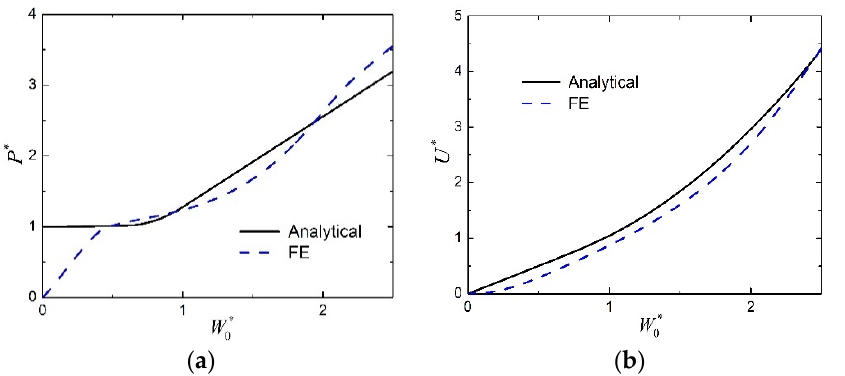
Figure 5. Comparison between analytical predictions and numerical results for the large deflection response of FML sandwich beams under transverse loading (Case 1): ( a ) Load versus midspan deflection; ( b ) absorbed energy versus midspan deflection.